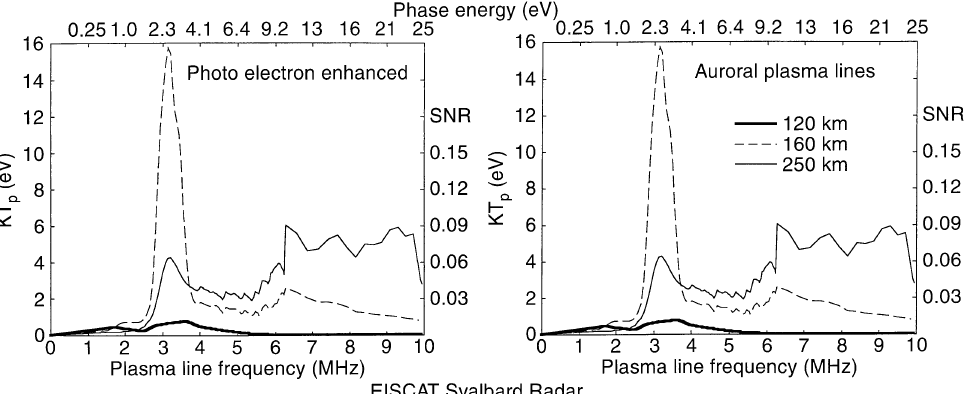
conditions (see text for details). The lower x - axis gives the plasma line frequency, while the upper gives the phase energy for the reso- nant electrons (for comparisons with Fig.